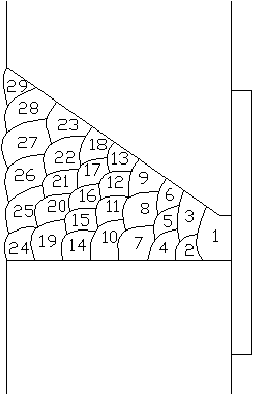
Figure 14. Groove welding layer and track indication.